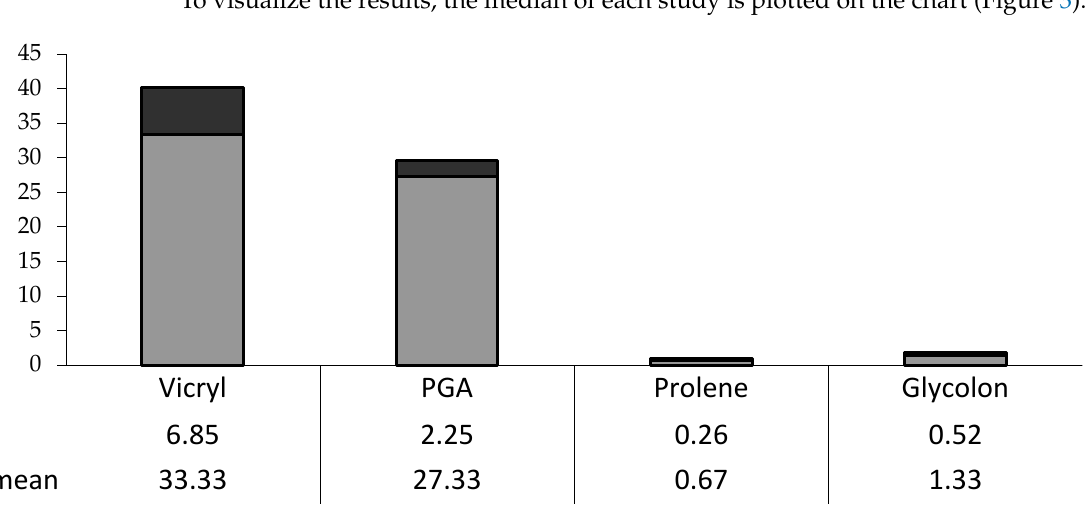
Table 2. Results of the study of suture materials mechanical properties .